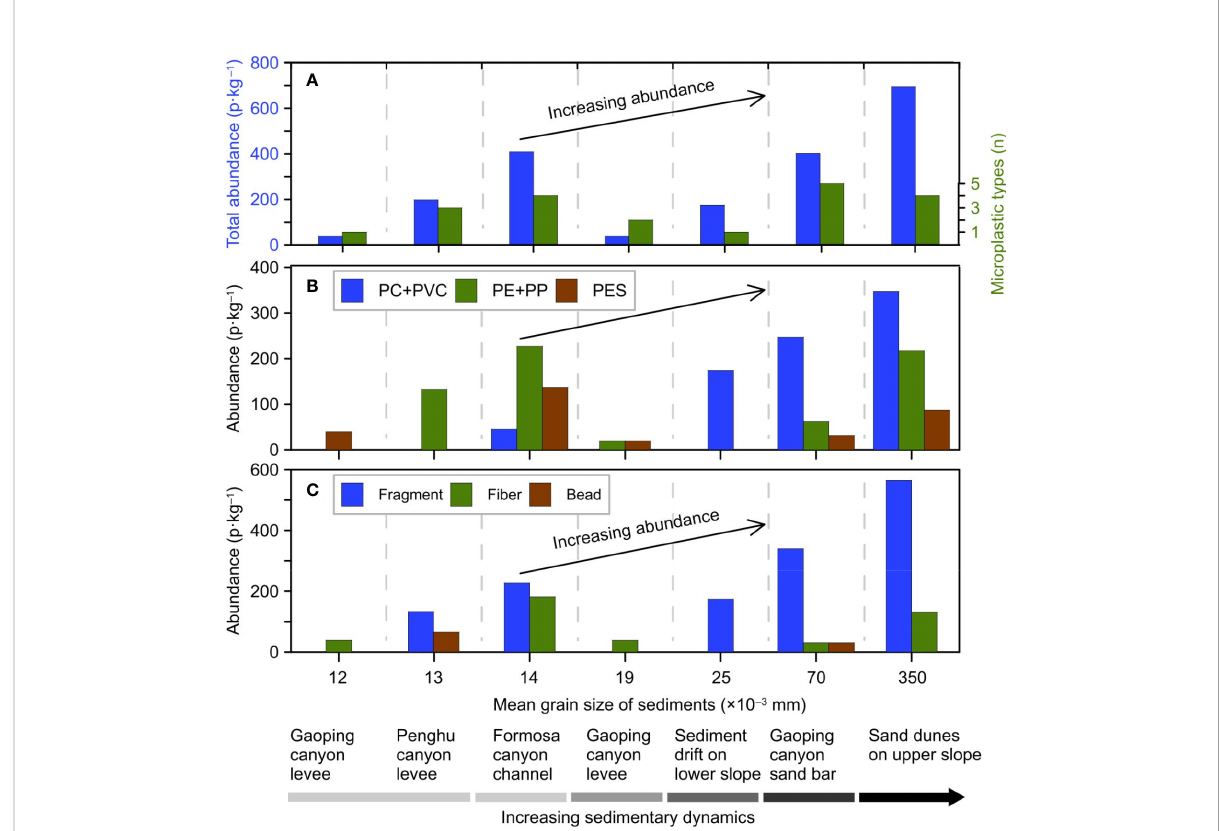
FIGURE 9 Correlation between the abundance of microplastics and the sedimentary dynamic conditions of deep-sea geomorphological units in the northern South China Sea. (A) Histograms of the total abundance and type of microplastics. (B) Abundance histograms of PC+PVC (high-density group in Figure 8), PE+PP (low-density group in Figure 8), and PES (synthetic fi ber in Figure 8). (C) Abundance histograms of microplastic fragments, fi bers, and beads. Deep-sea geomorphological units are arranged along the horizontal axis based on the mean grain size of detrital sediments, representing gradual increasing sedimentary dynamic intensity of the geomorphological